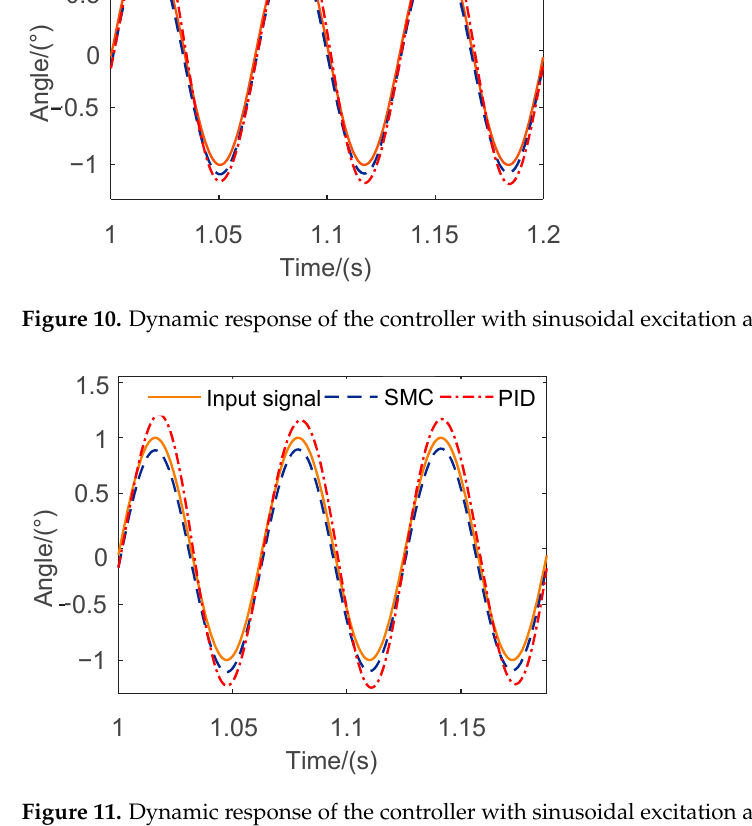
Figure 11. Dynamic response of the controller with sinusoidal excitation at 16 Hz and 1°.